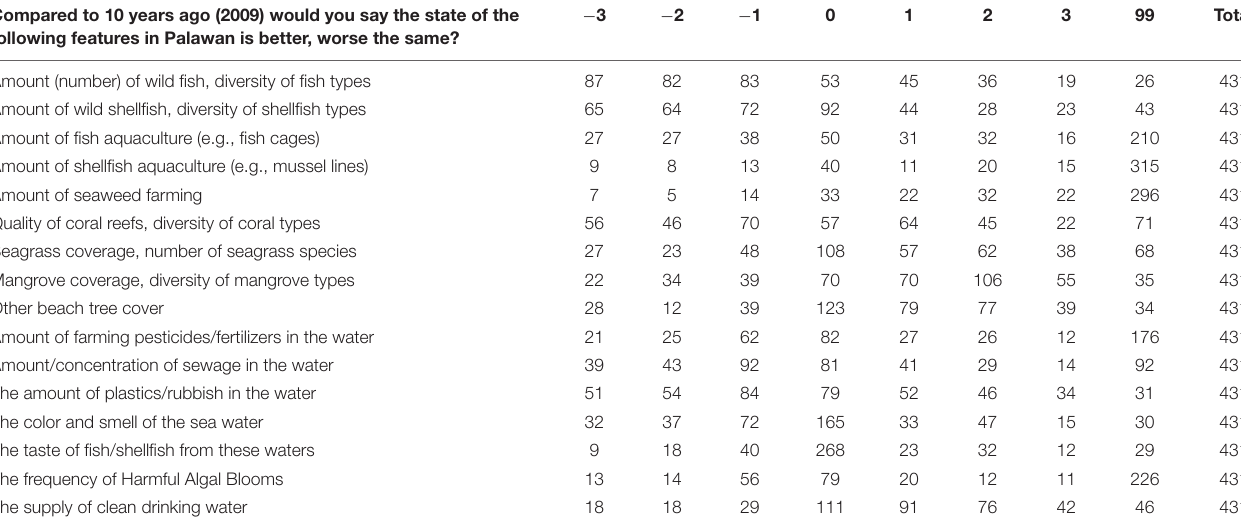
TABLE 4 | Distribution of answers among respondents for future expectations with the following choices: much worse = − 3, slightly worse = − 2, worse = − 1, the same = 0, better = 1, slightly better = 2, much better = 3, and prefer not to answer = 99. Compared to 10 years ago (2009) would you say the state of the following features in Palawan is better, worse the